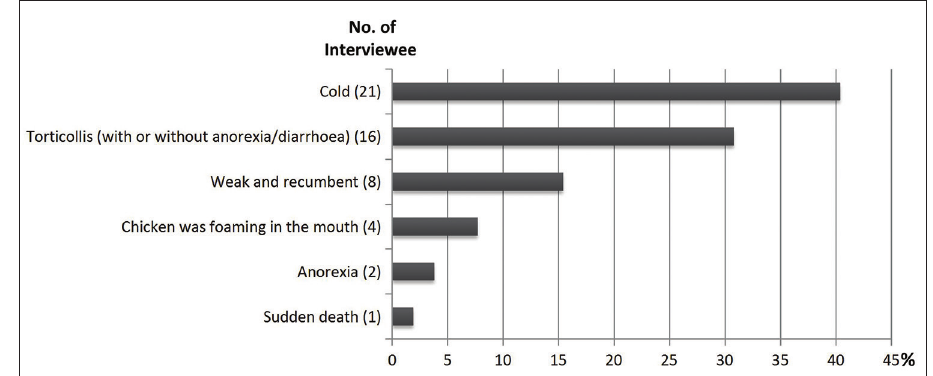
Figure-1: Percentage of clinical sign(s) shown before death. Percentage was calculated based on the number of interviewee who had experienced